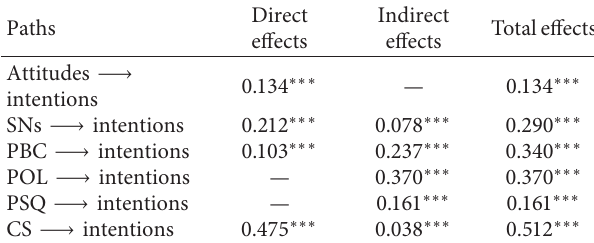
7: Standardized coefficients of the direct and total effects of the predictor variables on the endogenous variables and model fit